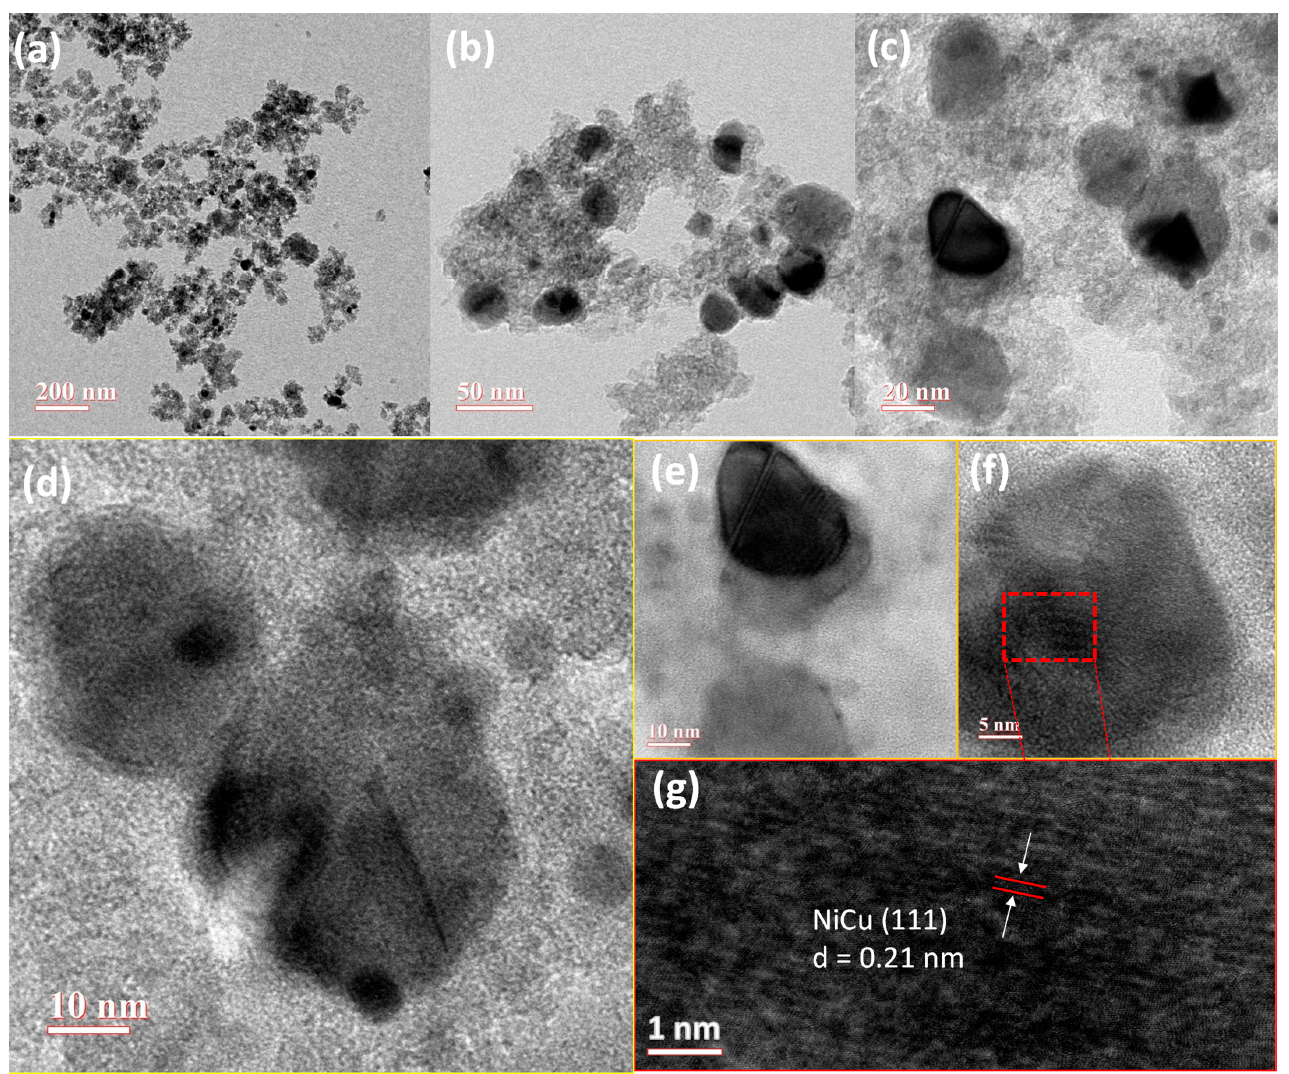
Figure 4. ( a ) TEM image of Ni 5 Cu 15 /m-SiO 2 catalyst; ( b – f ) HRTEM image of Ni 5 Cu 15 /m-SiO 2 catalyst; ( g ) Expend view of selected area with red rectangle shape in ( f ).